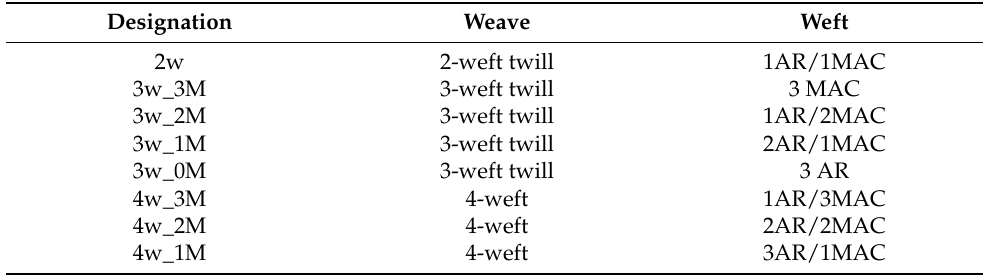
Figure 3. Peg plans and fabric simulation of samples ( a ) 2-weft; ( b ) 3-weft and ( c ) 4-weft. The composition of the warp was 95/5% Meta Aramid Conex NEO/Para Aramid Twaron raw yarn (hereinafter AR) with a fineness of 16.7 × 2 tex and the weft composition was 45/55% Cotton Long Staple Combed/Modacrylic Sevel FRSA/L (hereinafter MAC), fineness 25 tex. The description of the samples is shown in Table 1. Table 1. Description of designed and woven fabric samples.